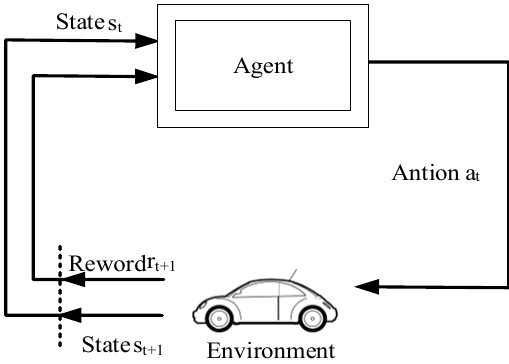
Figure 5 . Basic principle of RL. Figure 5. Basic principle of RL.